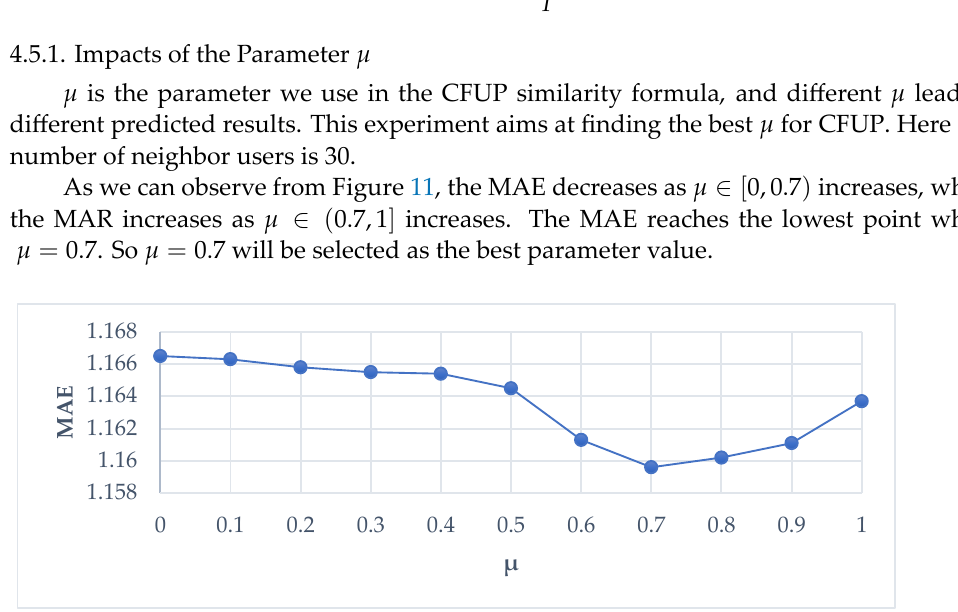
Figure 11. The impact of parameter μ on MAE.